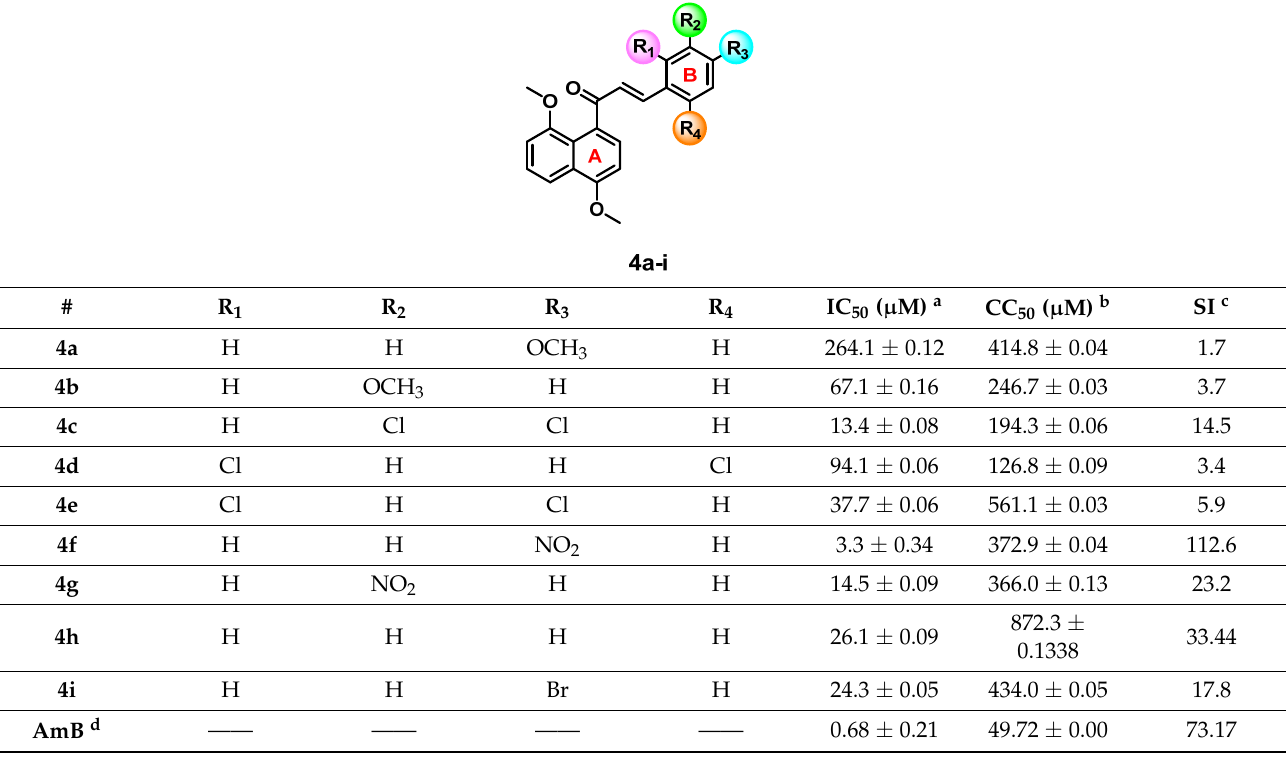
Table 1. In vitro antileishmanial activity against promastigotes forms (IC 50 ), cytotoxicity.